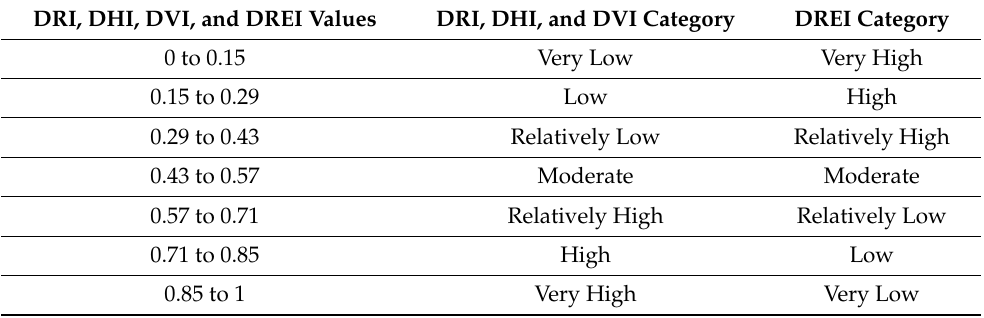
Table 1. Categorization of DRI, DHI, DVI and DREI.